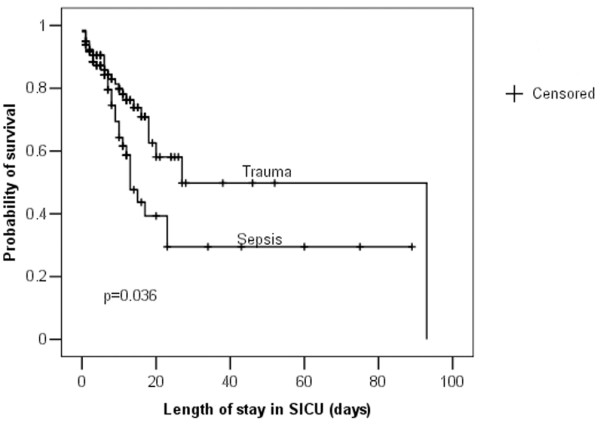
Surgical ICU mortality. The Kaplan-Meier survival curve shows that patients with sepsis had higher surgical ICU mortality than did patients with trauma. ICU, intensive care unit.